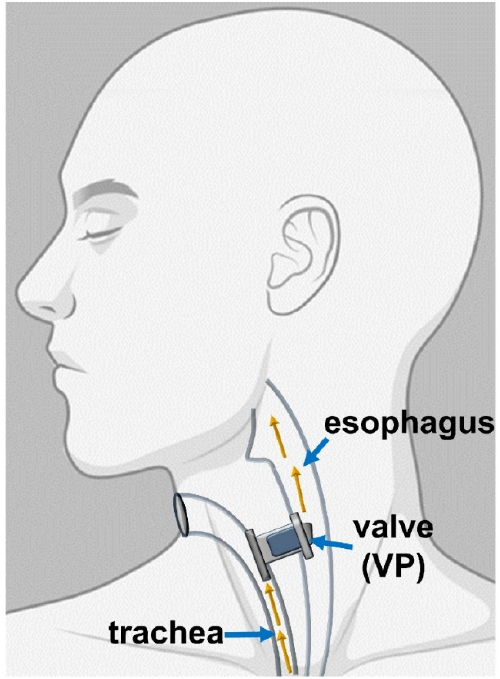
Figure 5. Representation of the placement of the VP (Reprinted from an open-access source) [83].